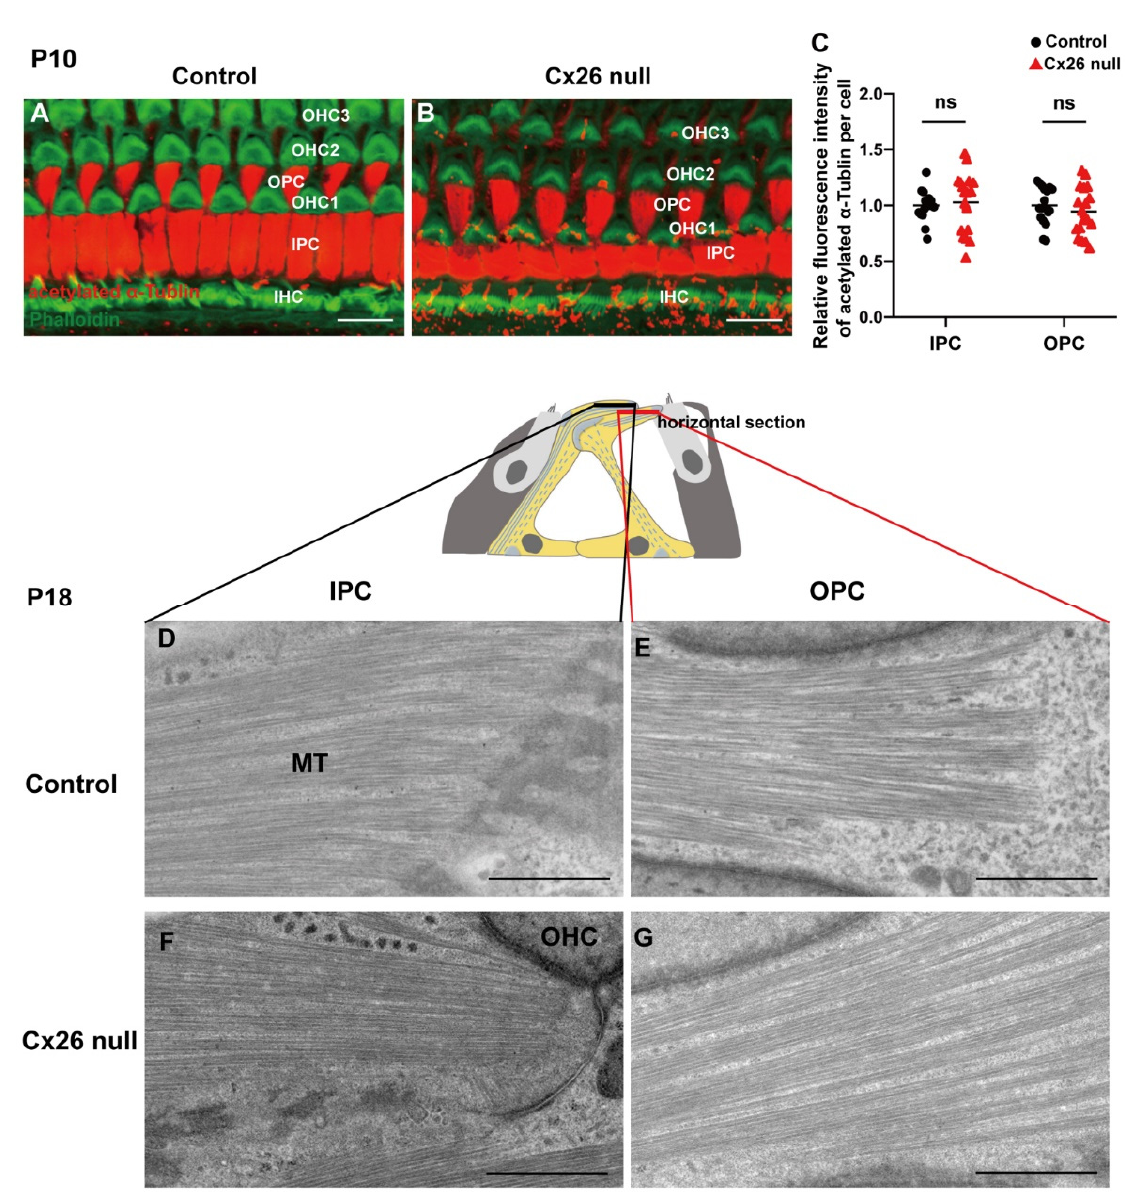
Figure 4. Normal organization of MTs, which are anchored at non-centrosomal MTOCs near cen- trosome. ( A , B ) Immunofluorescence staining of acetylated α -Tubulin in the apical cochlea at P10. ( C ) Quantification of immunolabeling for acetylated α -Tubulin in IPCs and OPCs from the control and Cx26-null groups (18 IPCs and 18 OPCs from 3 mice in each group) at P10. The assessed levels are displayed in plot A,B. The relative fluorescence intensity of acetylated α -Tubulin: 1.00 ± 0.03 (control) vs. 1.03 ± 0.06 (Cx26 null) in IPCs, 1.00 ± 0.04 (control) vs. 0.95 ± 0.05 (Cx26 null) in OPCs—data